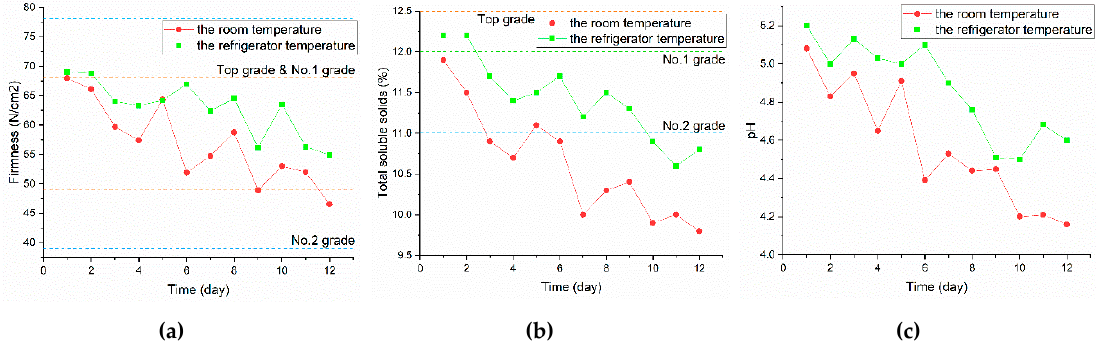
Figure 7. The quality evaluation results of physicochemical index for fragrant pears in different home storage conditions. ( a ) The evaluation results of firmness. ( b ) The evaluation results of total soluble solids. ( c ) The evaluation results of pH.